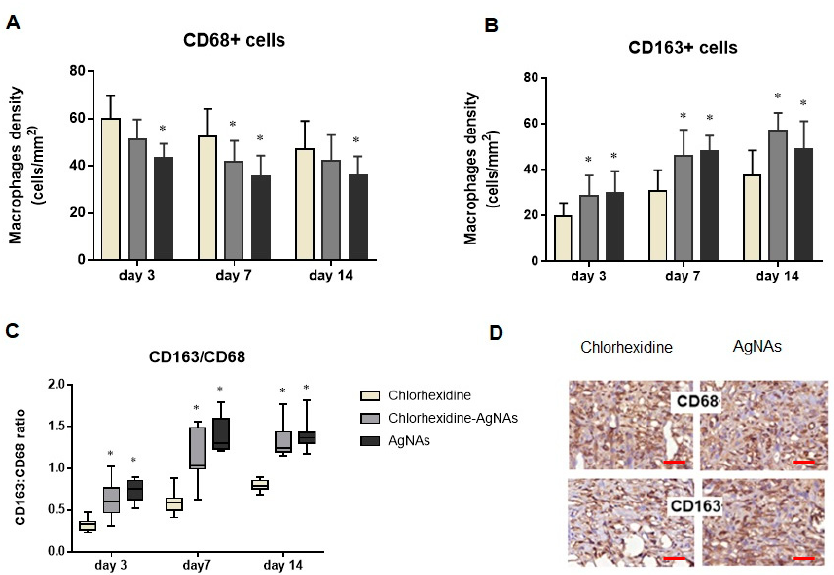
Figure 7. Number of M1 and M2 macrophages during wound healing in rats with different treatments of wounds. The graphs in ( A ) and ( B ) demonstrate changes in the number of CD68+ and CD163+ cells, respectively; the graph in ( C ) indicates a comparison of the CD163/CD68 ratios reflecting M2 macrophages polarization; photographs in ( D ) (scale bar—100 µ m) illustrate differences in various macrophage numbers in the group treated with chlorhexidine compared with AgNAs application.